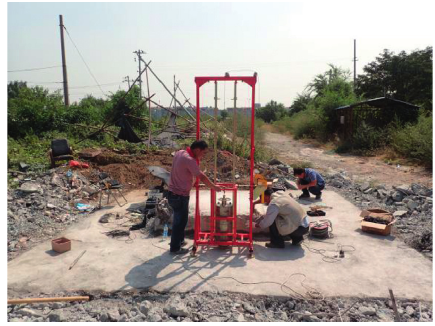
Figure 10: Impact on the cap-pile system by the drop weight setup when the pier was cut off.